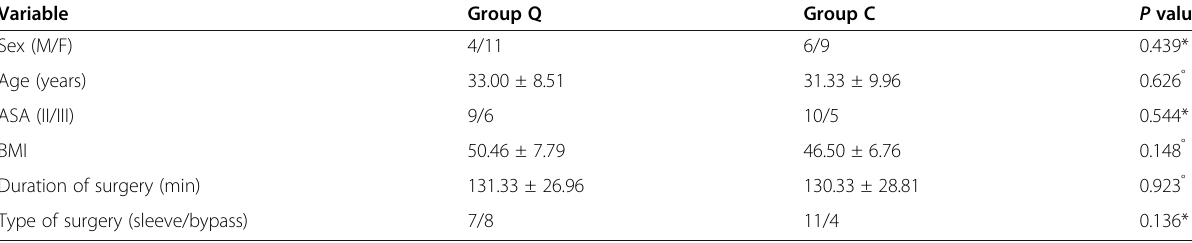
Type of surgery (sleeve/bypass) Data presented as mean ± SD or count ° Measured by the independent t -test *Measured by the chi-square